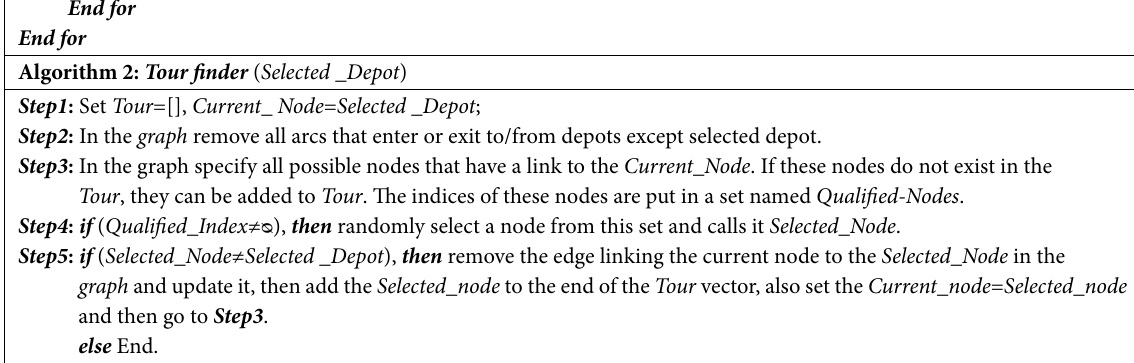
Figure 4. Pseudocode of the constructive